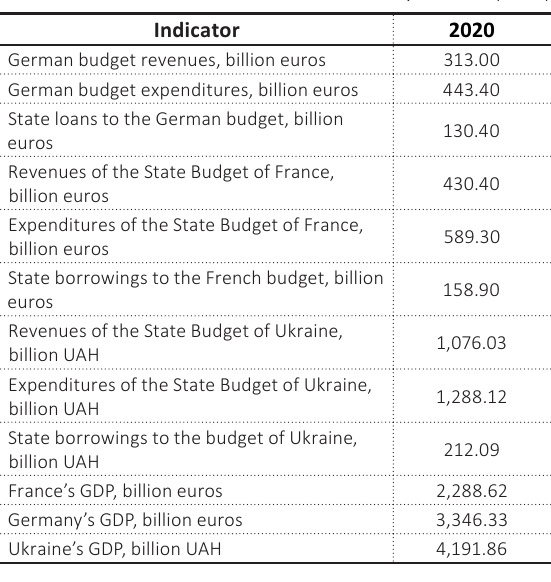
Table 1. Indicators of revenues, expenditures, state borrowings, and GDP of Germany, France, and